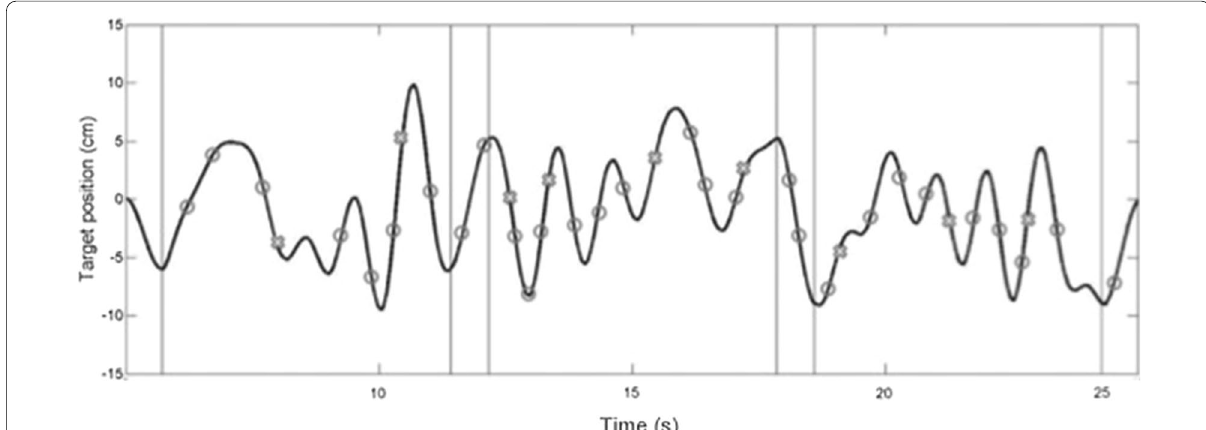
Fig. 6 An example of a sequenced dual-task trial in Experiment 2a. A tracking target followed the sinusoidal path, which was invisible to the participants. Circles along the tracking path represent the occurrence of distractor sounds; crosses along the tracking path represent target sounds. All sounds had varying inter-stimulus intervals. The only regularity in the predictable condition was the occurrence of a target sound every fourth